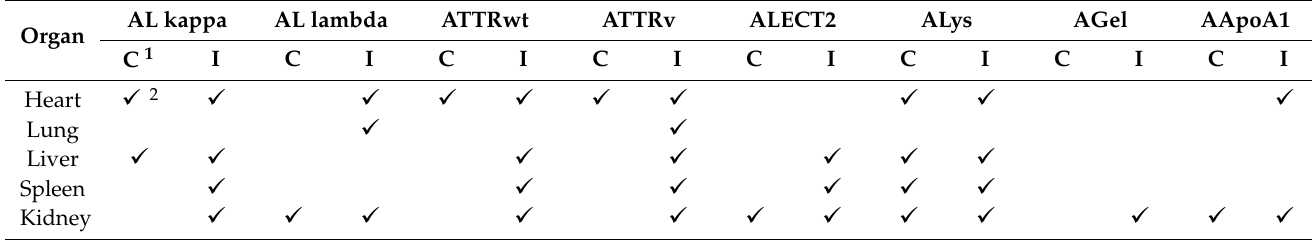
1 C, clinical distribution of amyloid based on medical record; I, imaging distribution of amyloid based on 124 I-p5+14 uptake. 2 Positive uptake of the radiotracer ( ) is the result of a stringent, clinical read by a nuclear medicine physician using appropriate visualization software and window param- eters for each organ. Therefore, this distribution may not be obvious in the MIP images (Figure 3), which are not threshold dependent, nor the coronal PET/CT images (Figure 5), which capture the distribution of radioactivity in a single slice.